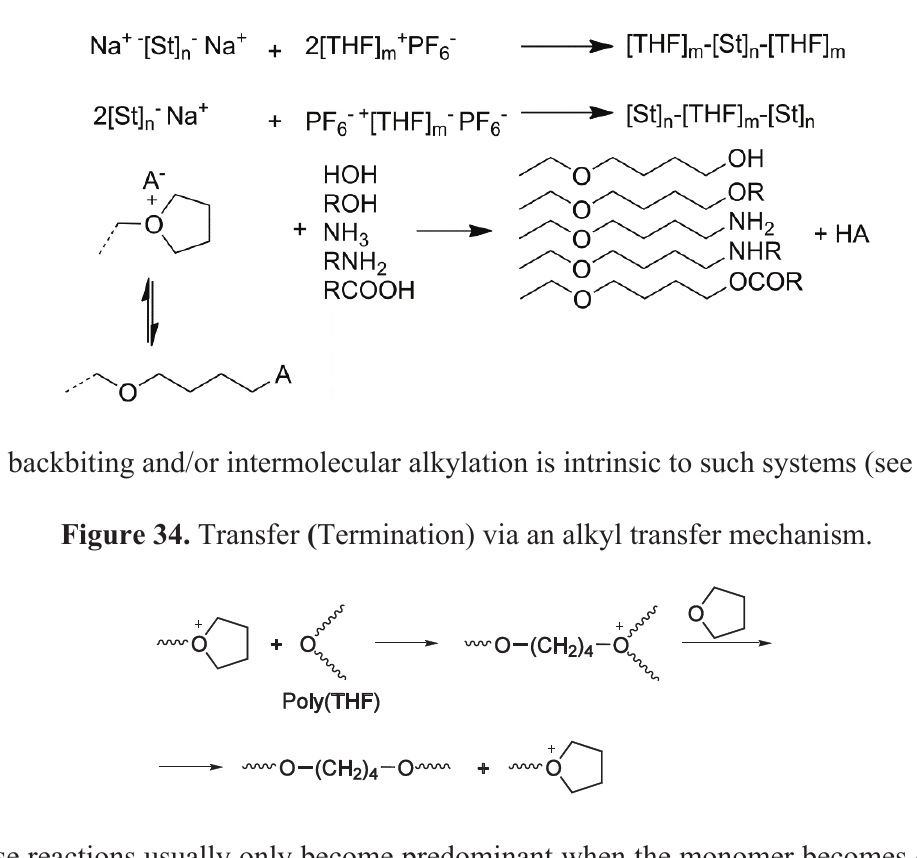
Figure 33. Intentional termination of CROP.